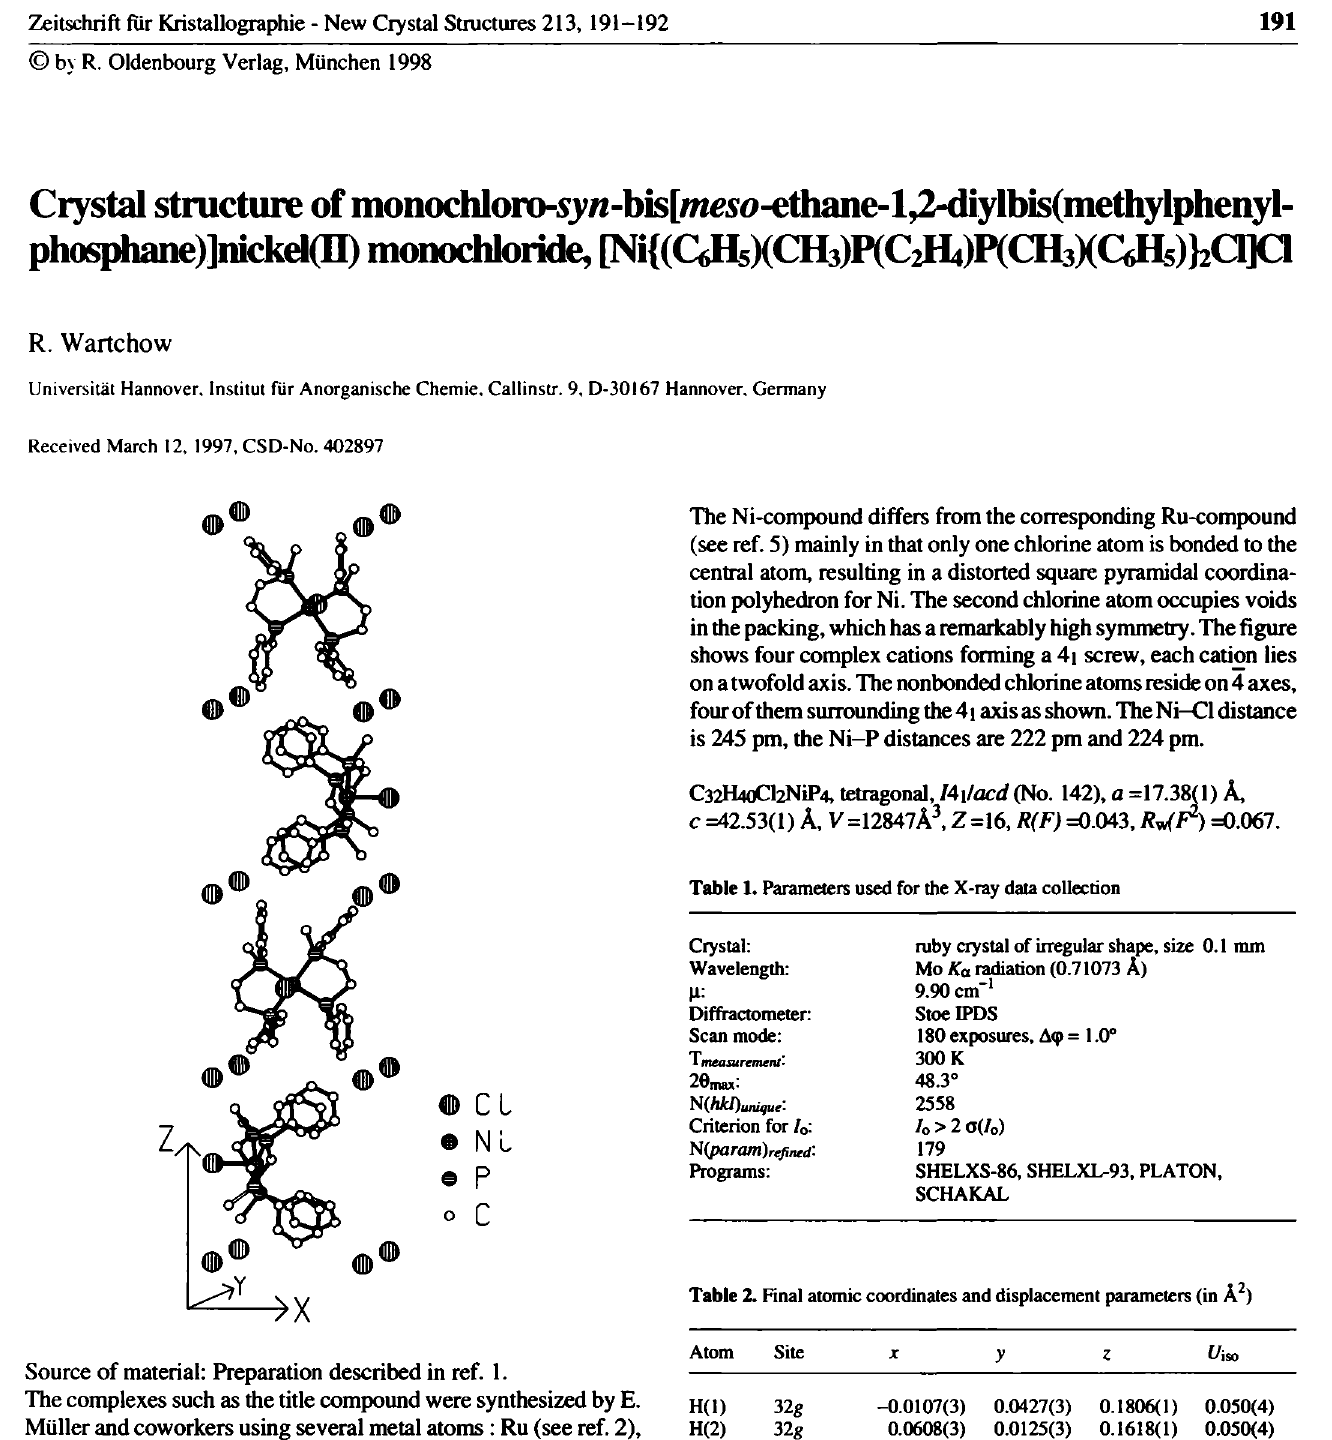
Table 1. Parameters used for the X-ray data collection Crystal: ruby crystal of irregular shape, size 0.1 mm Wavelength: